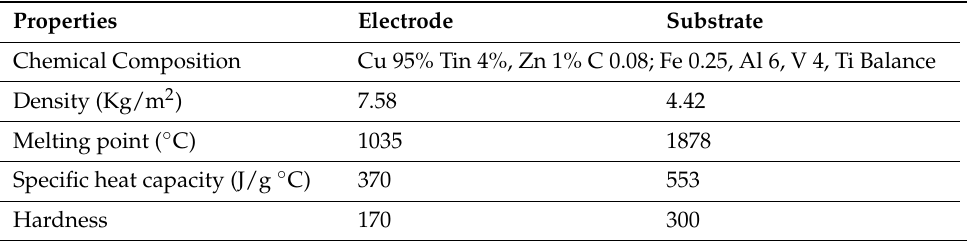
Table 1. Physical and chemical composition of electrode and substrate.